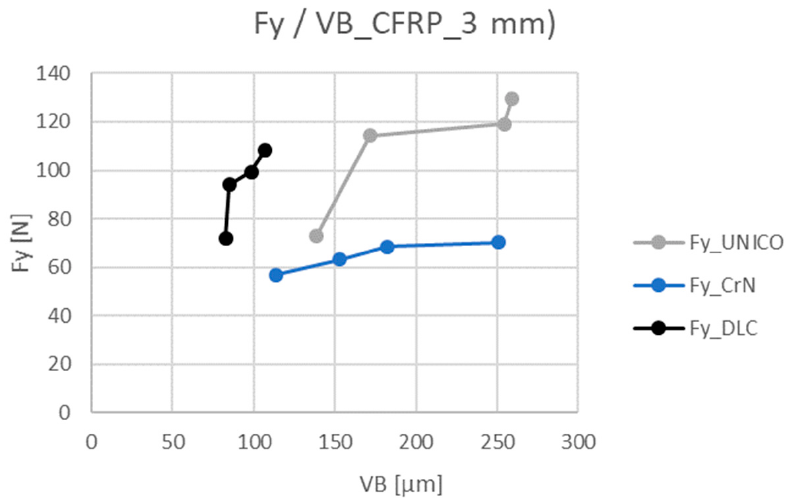
Figure 16. Dependence of the cutting force component F y on wear, laminate thickness 3 mm. F x — cutting force in x direction. VB—flank wear.